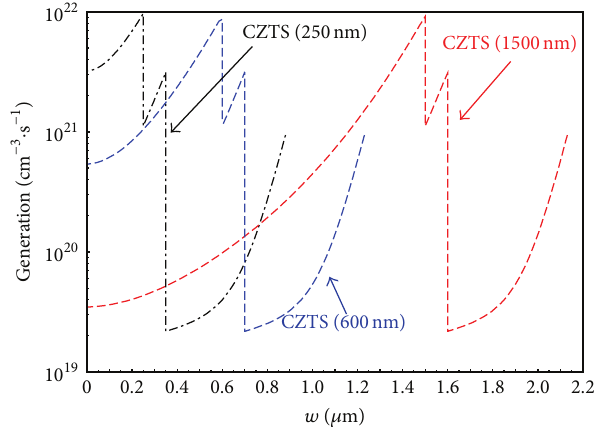
Figure 5: Generation profile obtained from our CZTS solar cell baseline.